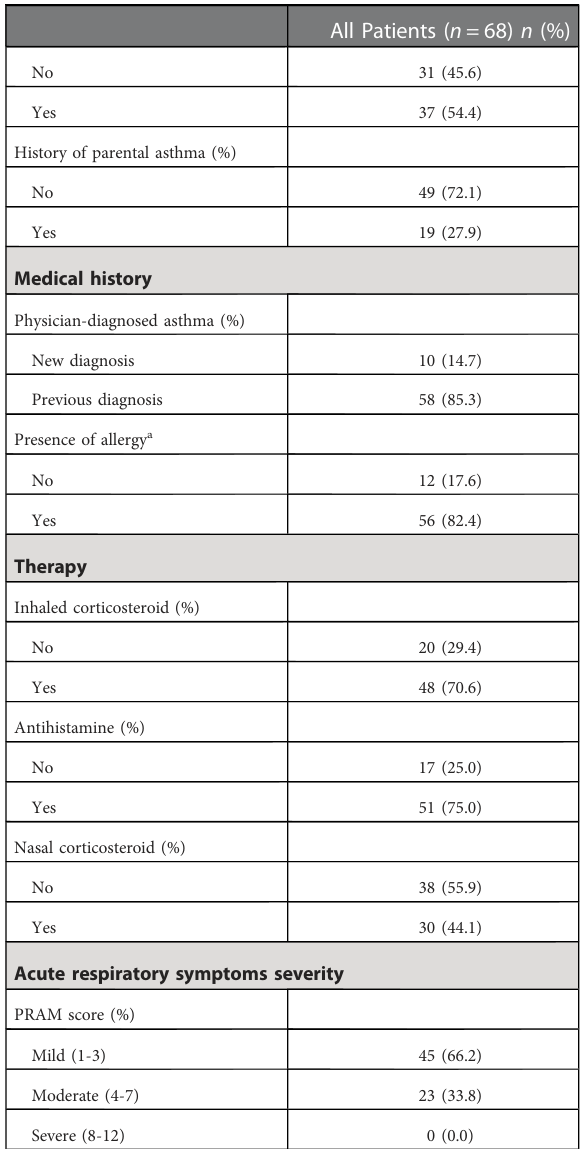
TABLE 1 General characteristics of our study